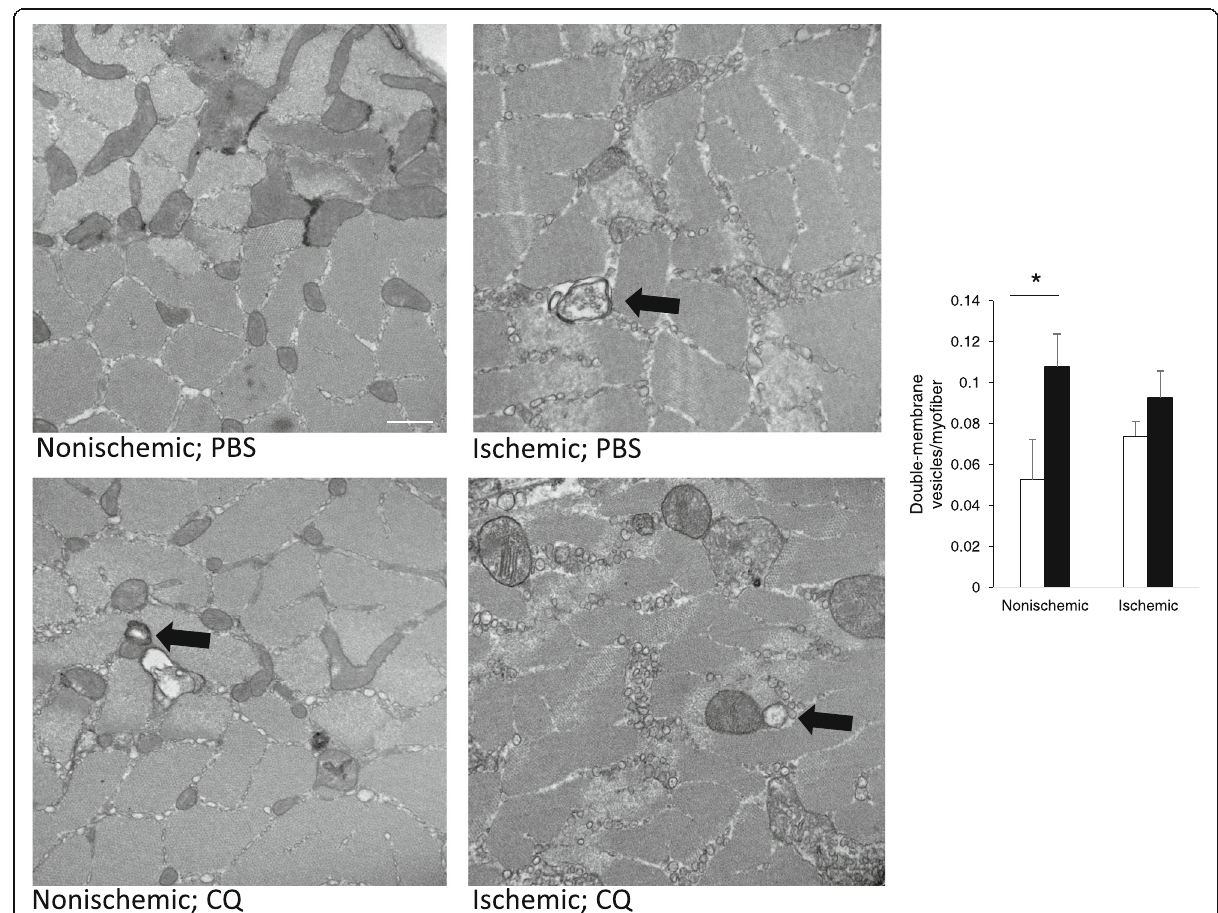
Fig. 2 CQ increases double-membrane autophagosomes in nonischemic muscle. Transmission electron microscopy images of cross-sections of tibialis anterior muscle harvested from at 24 h from nonischemic and ischemic hindlimbs from WT C57Bl6/J mice treated with either PBS or CQ (50 mg/kg) for 21 days prior to the initiation of unilateral femoral artery ligation (FAL). Images captured at 30,000x magnification. Autophagosomes were identified as double membrane vesicles (arrows) and quantified as a function of the number of myofibers per image. A minimum of 5 images per limb/animal were evaluated. Representative images shown. * p < 0.05, PBS:CQ nonischemic limb, N = 3 mice per treatment, 5 images/limb for each mouse; Scale bar = 500